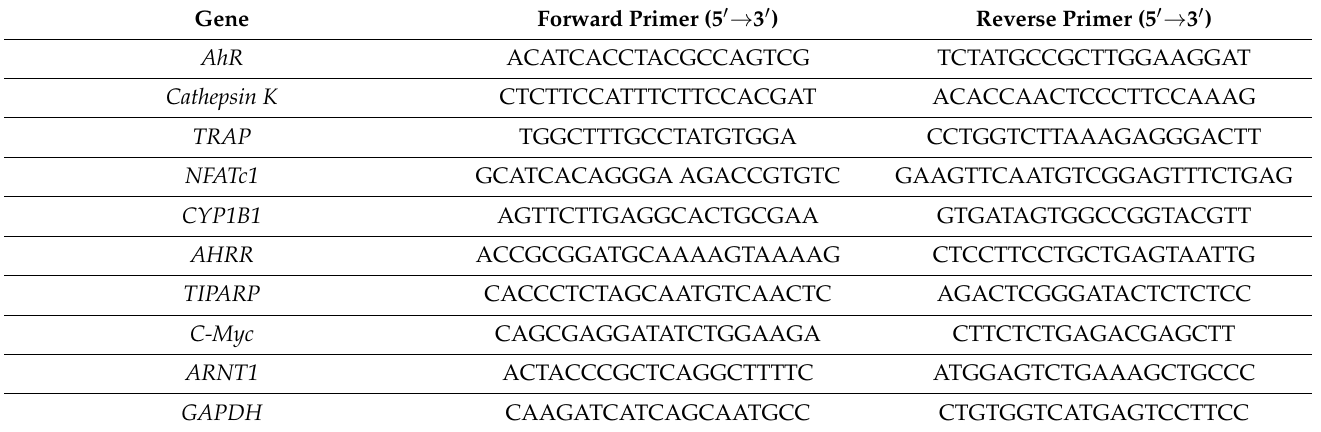
Table 1. RT-qPCR primer